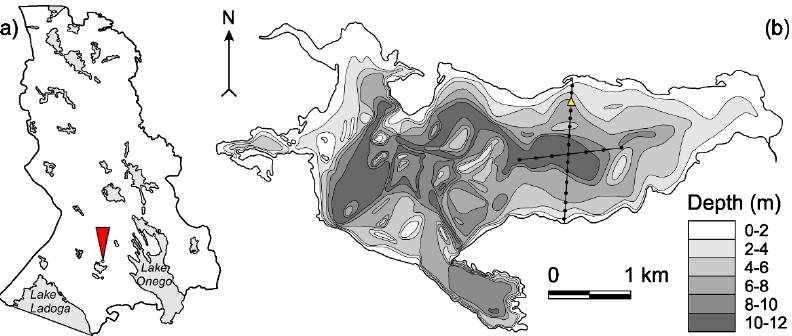
Figure 1. ( a ) Geographic location of Lake Vendyurskoe, red triangle. ( b ) Lake Vendyurskoe bathymetry and location of measurement stations and transects. The yellow triangle indicates the station of solar radiation measurements.